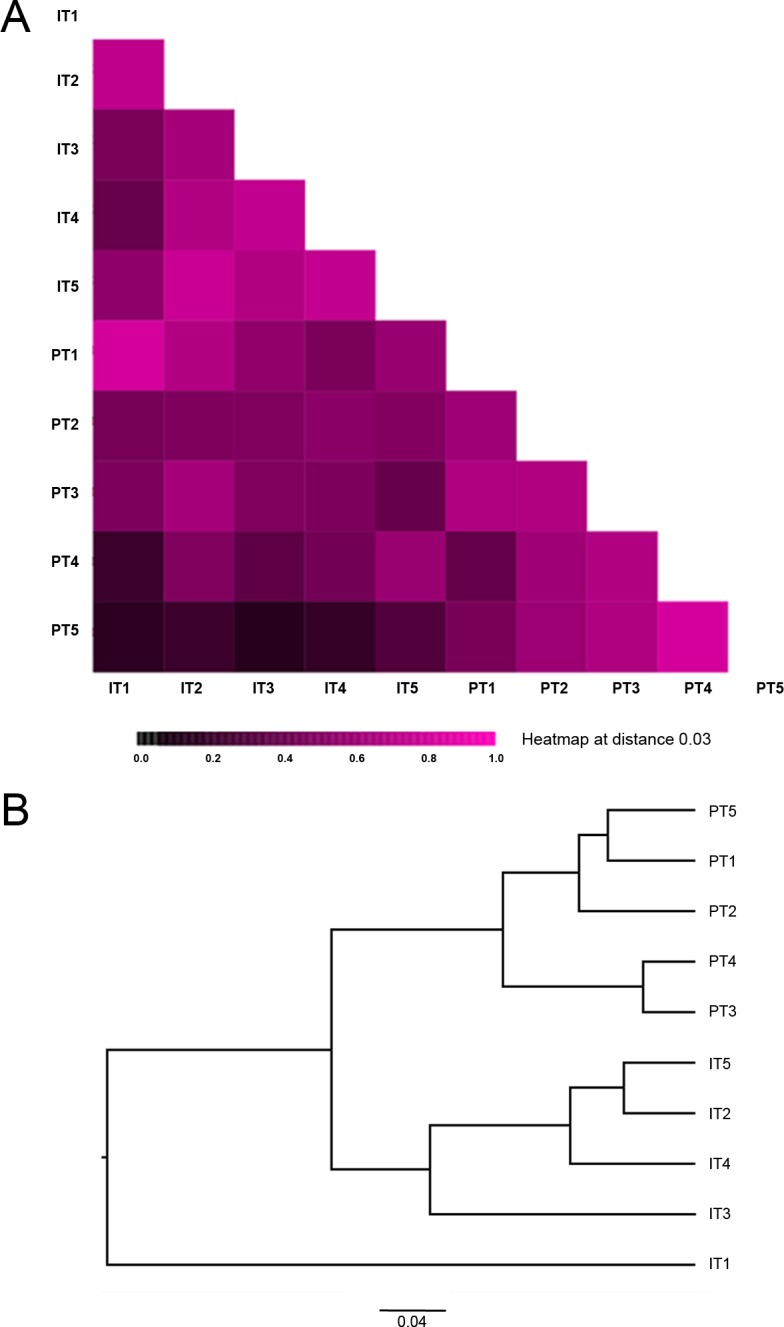
Heatmap (A) and Phylogenetic Tree (B) of Morisita-Horn diversity indices between nares microbiota derived from infants (I) and their primary caregivers (P) at each time point (T1-T5). A) Gradations in the shading intensity reflect the degree of similarity for Morisita-Horn diversity indices between sampling time points, with darkest hue intensities denoting most dissimilarity (approaching a Morisita-Horn diversity index value of 0.0) and brightest hue intensities denoting the most similarity (diversity index value approaching 1.0). B) Phylogenetic distance was calculated using the unweighted pair group method with arithmetic mean (UPGMA) for each time point, based on a random subsampling of 25,000 OTUs from all subjects per group. The scale bar depicts an inferred phylogenetic distance (Morisita-Horn diversity index) of 0.04 (no units).